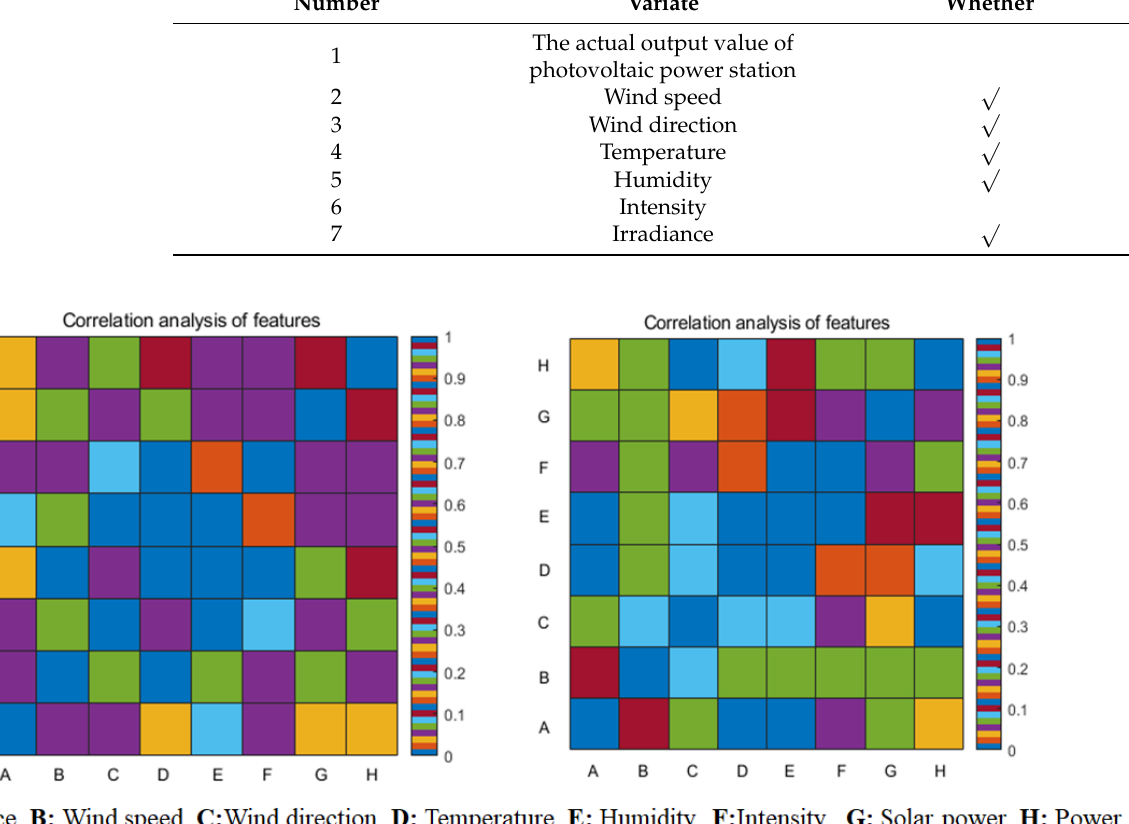
Figure 9. Selection table of characteristic factors. Table 1. Data composition of sample points.